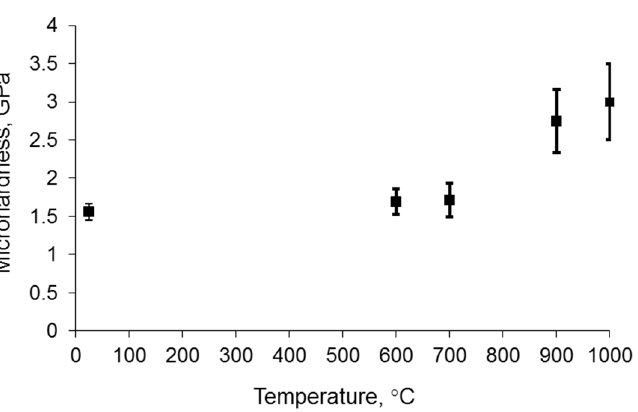
Figure 5. Change in the microhardness of the Ti–Al samples after Si + implantation during heat treatment 600–1000 °C.